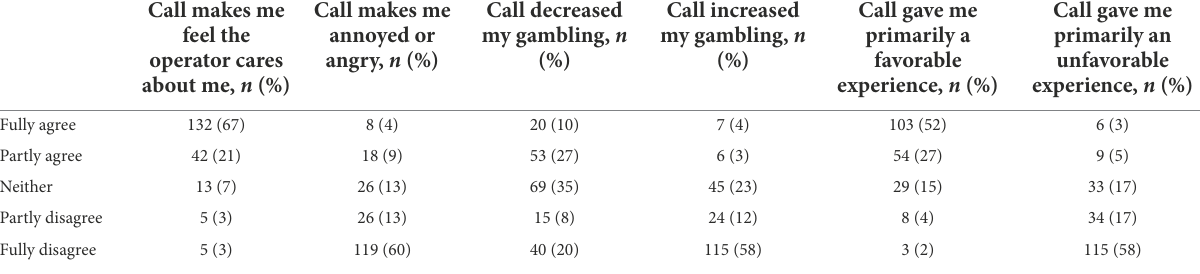
TABLE 1 Subjective patient satisfaction with the motivational telephone intervention ( N =